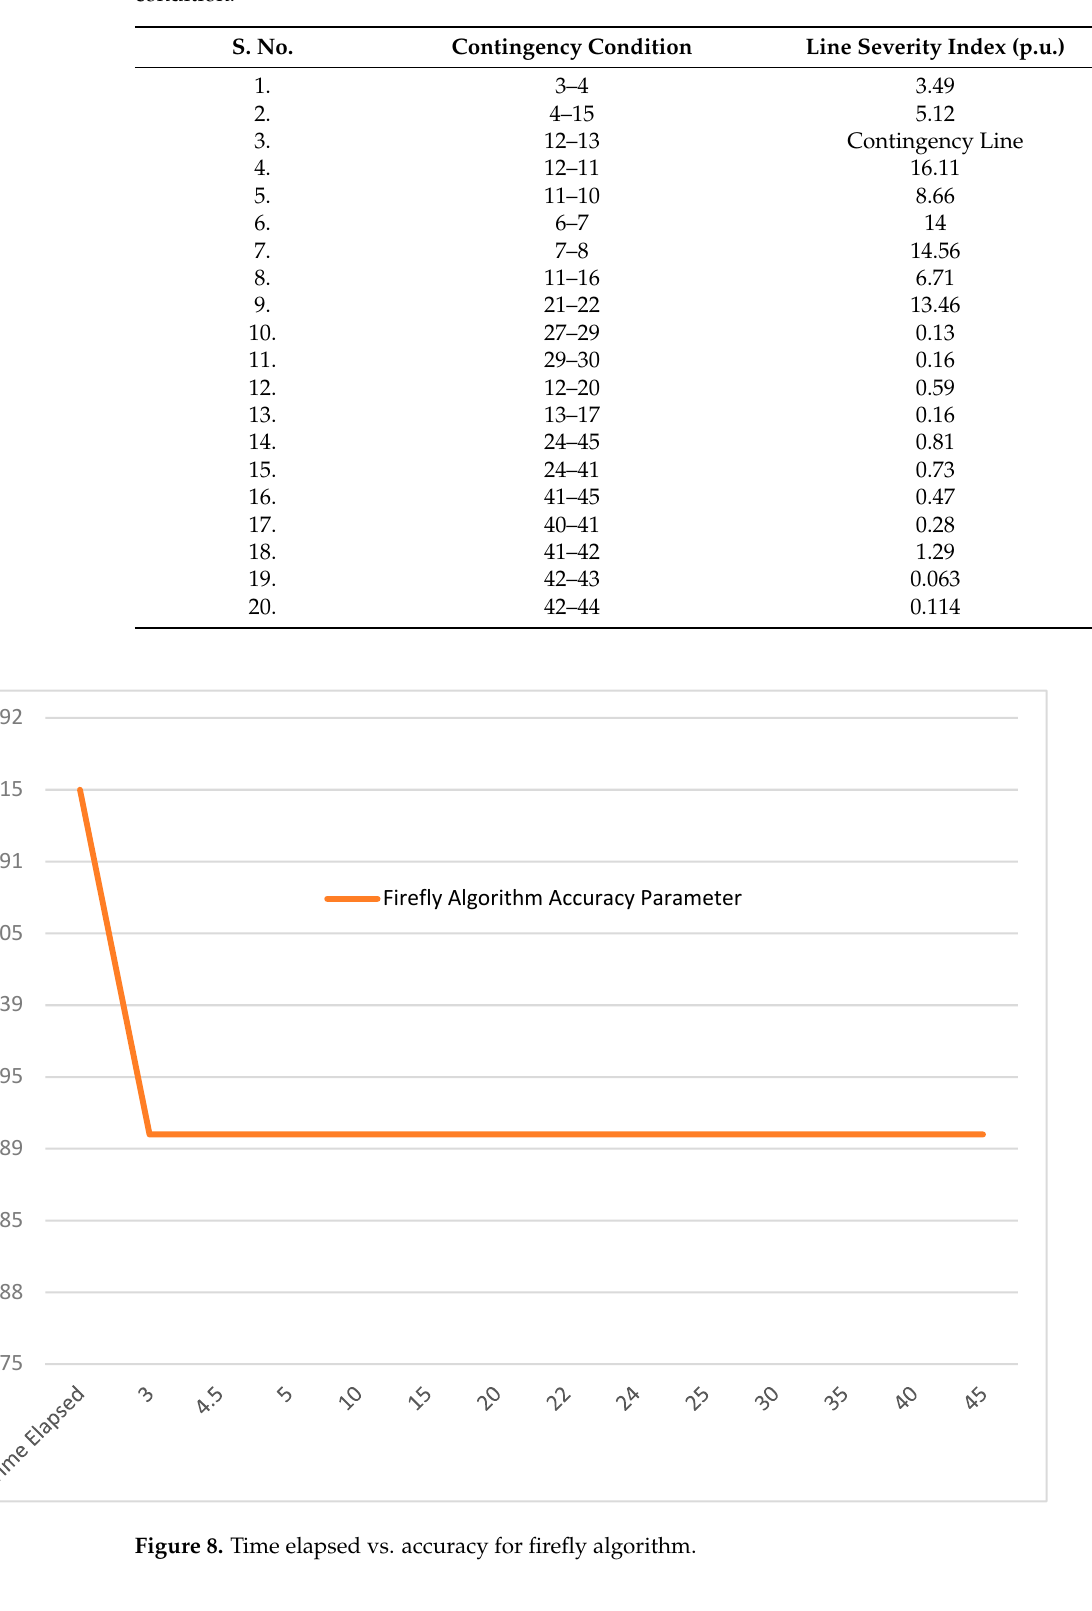
Table 2. Line Severity Index of transmission lines connected to load buses for line 12–13 contingency condition.